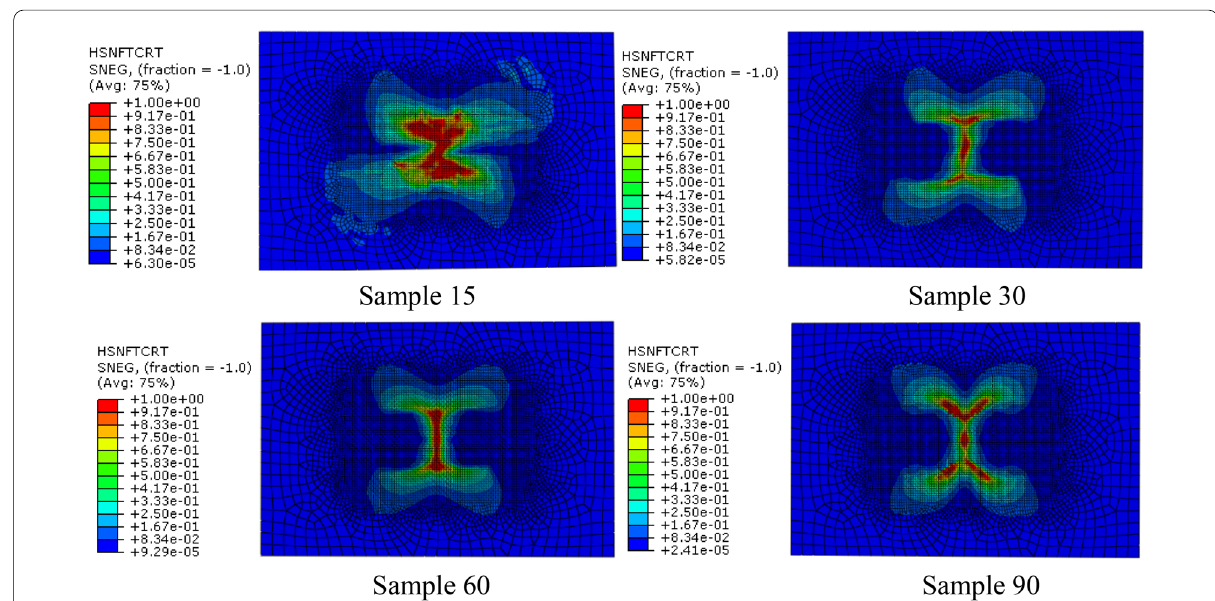
Fig. 7 Distribution nephogram of fiber tensile failure of four bionic models with different helix angles when impact energy is 20